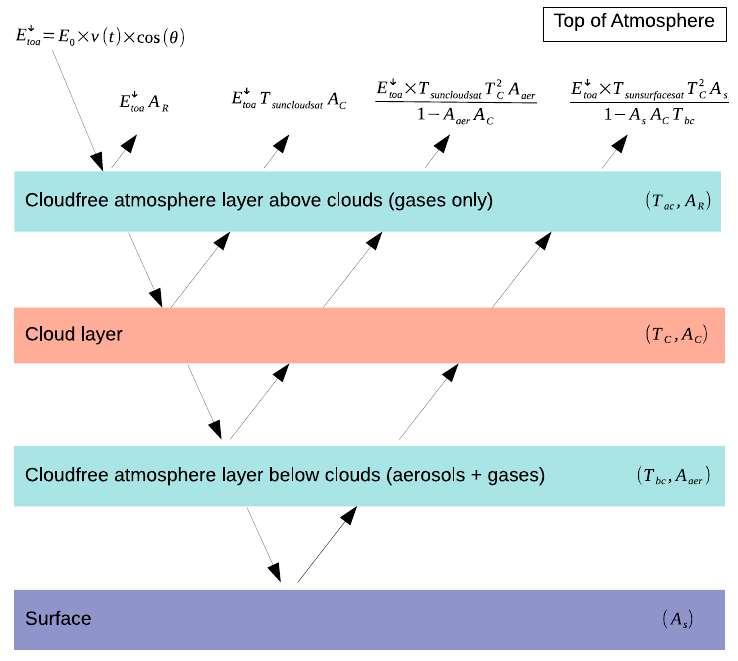
Figure 6. Schematic flow chart showing how the surface associated medium is represented by MDSSFTD simple radiative transfer scheme. The four terms of Equation (24) appear in the upper part of the scheme.